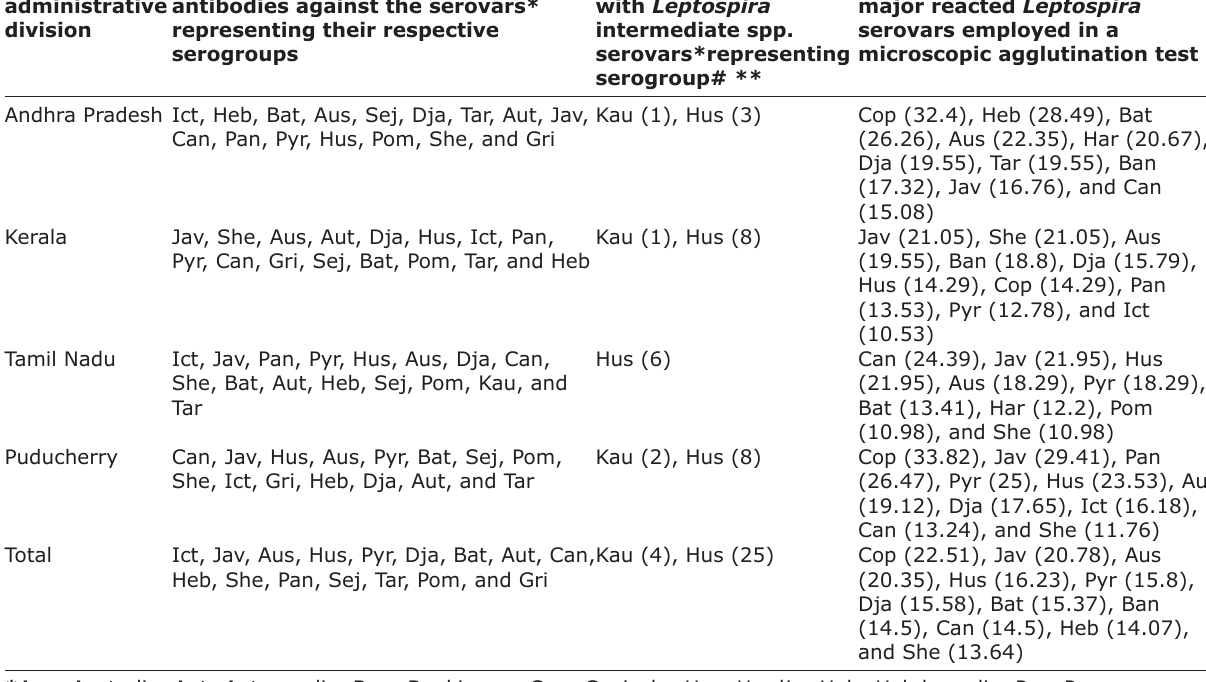
Table-2: Administrative division-wise details of the prevalence of anti-leptospiral antibodies by microscopic agglutination test. Name of the administrative